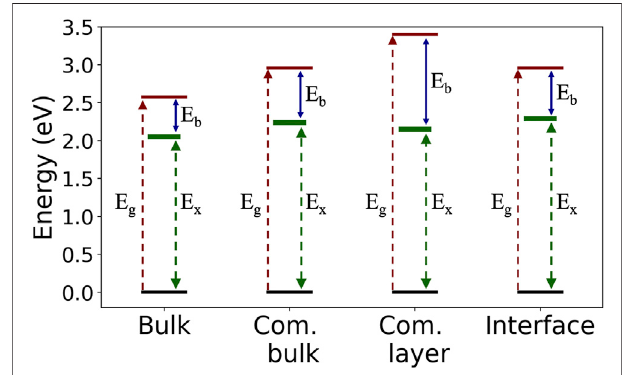
FIGURE4| SummaryofthecomputedGWquasiparticlegap, E g ;optical gap, E x ; and the exciton binding energy, E b , in the four examined